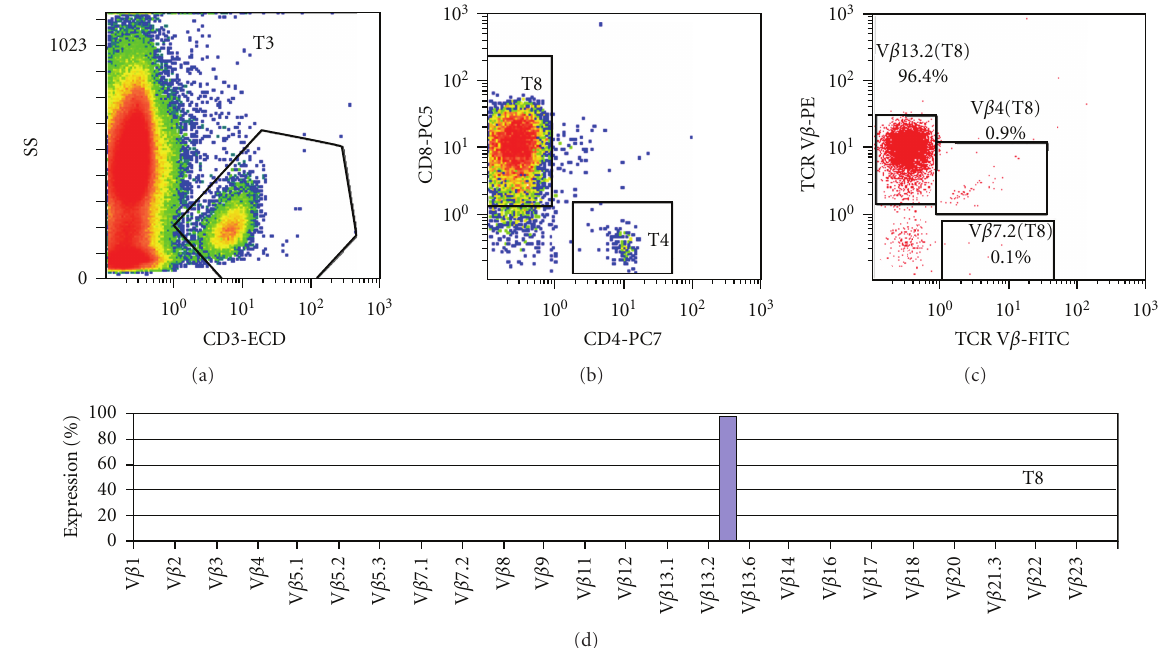
Figure 1: Flow cytometry of the bone marrow and peripheral blood of patient 2, showing a monoclonal TCR V β 13.2 T-cell population, CD3+, TCR αβ +, CD8+, CD7+, CD30+, EMA+, ALK − , of high mitotic index (Ki-67 =